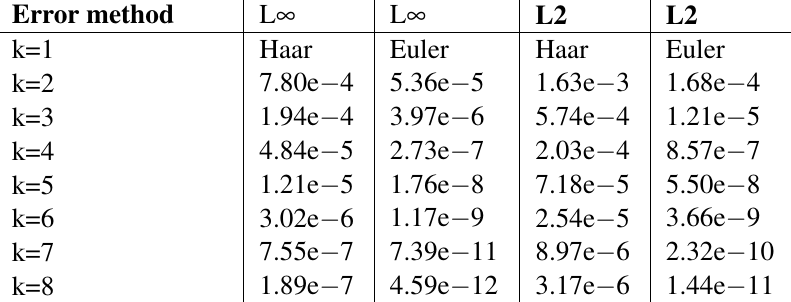
Table 1 Comparison of L ∞ and L2 errors under different parameters